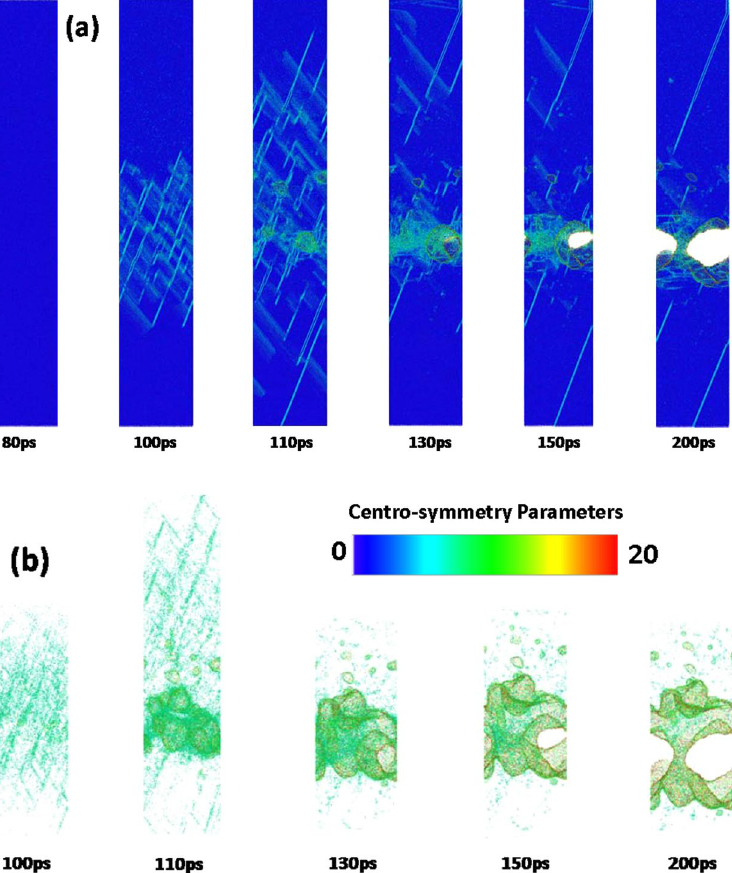
Figure 17. Snapshots of atomic centro-symmetry parameter in the 320–420 nm part of 450 nm 〈 111 〉 copper film under an absorbed laser intensity of 0.065 J/cm 2 at 80–150 ps time instant. The atoms are colored according to their centro-symmetry parameters, ( a ) 0 < CSP < 20, ( b ) CSP > 4.